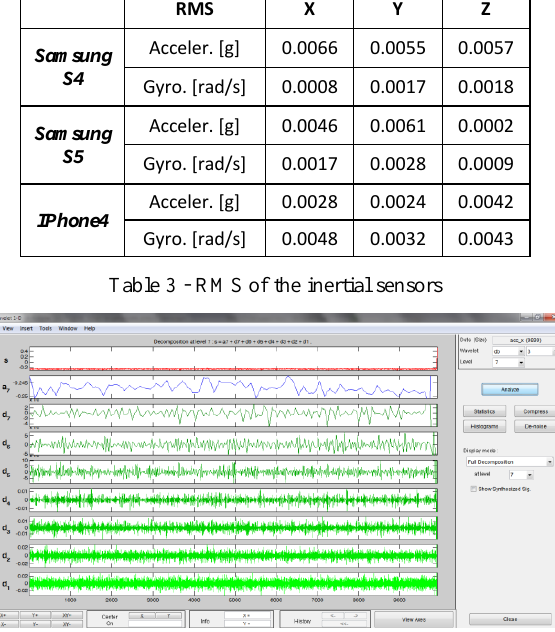
Figure 15 - Wavelet denoising